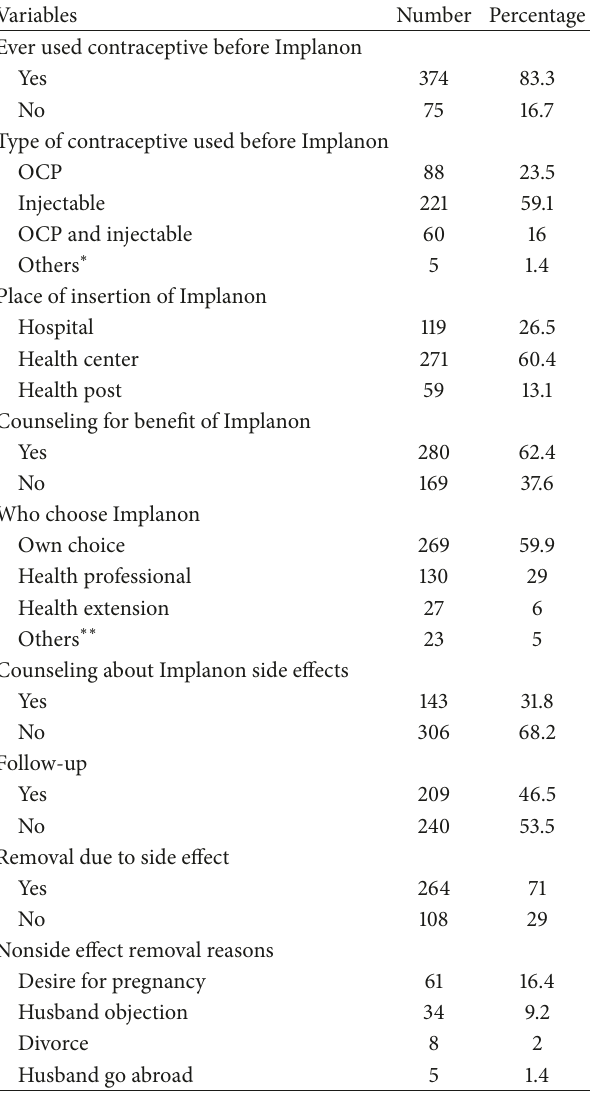
Table 3: Contraceptive related characteristics of study participants in Debre Tabor town public health facilities, northwest Ethiopia, August 2016 ( 𝑛 = 449 ).